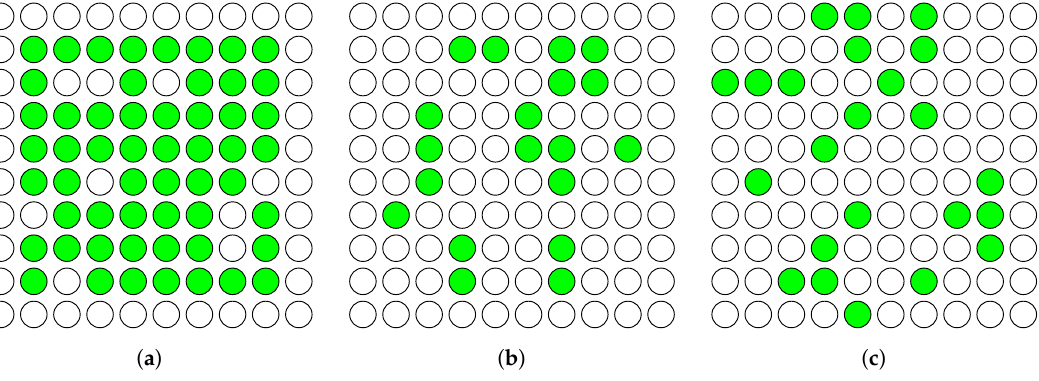
Figure 12. Constructed CDSs of three different network densities in simulations. The dominators are colored in green. Links between nodes are not illustrated due to their large number. A larger hop distance represents a smaller density of the network. Therefore, a network with a larger hop distance is required to have more dominators to cover the whole network. ( a ) Maximal hop distance: 9 hops. ( b ) Maximal hop distance: 5 hops. ( c ) Maximal hop distance: 3